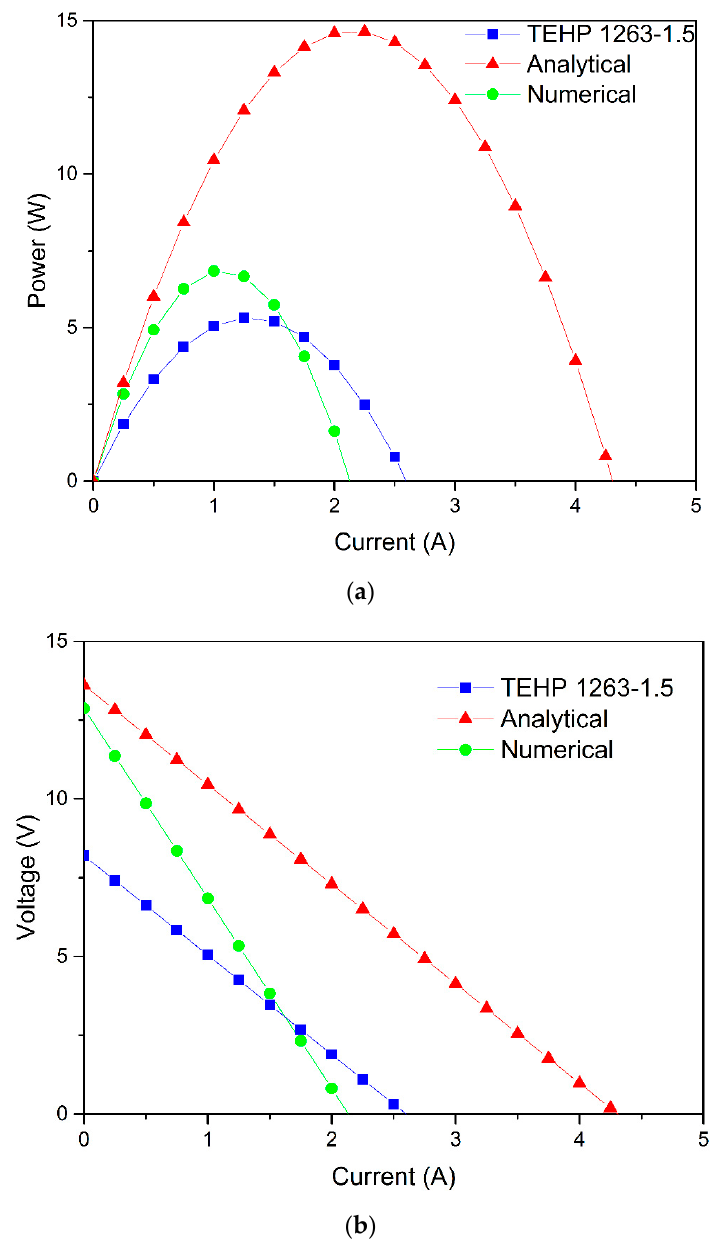
Figure 4. Output power ( a ) and charge voltage ( b ) behavior of the models compared to the manufacturer’s data of TEHP 1263-1.5 under load resistance of 2.96 Ω , T c = 30 °C and T h = 300 °C.